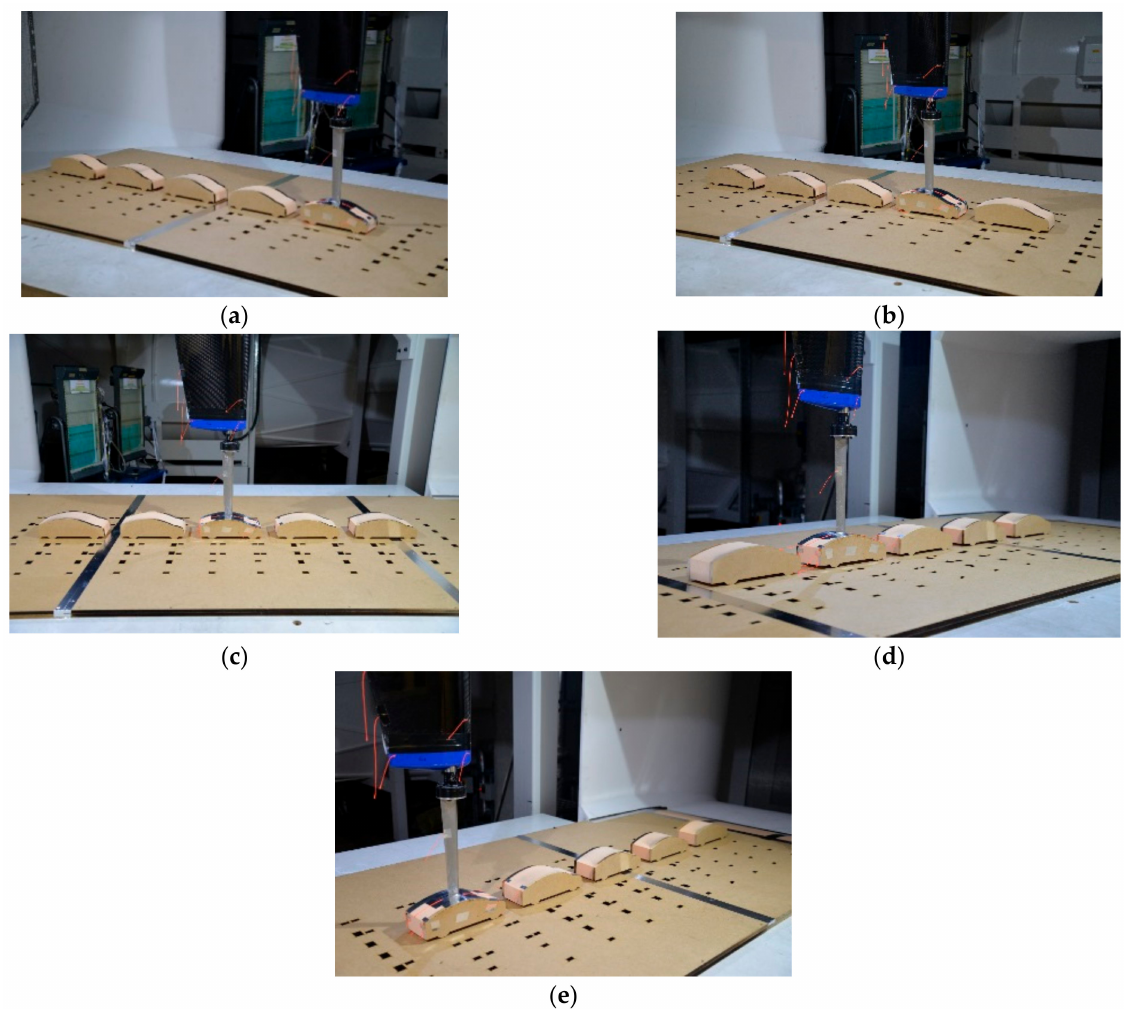
Figure 5. The positioning of models around the ‘measurement model’ to determine drag loads for each individual model comprising Configuration 5. The ‘measurement model’ is: ( a ) at front of platoon, ( b ) second in line, ( c ) in the centre position, ( d ) fourth in line, ( e ) at the rear of the platoon, after [50] © SAE International